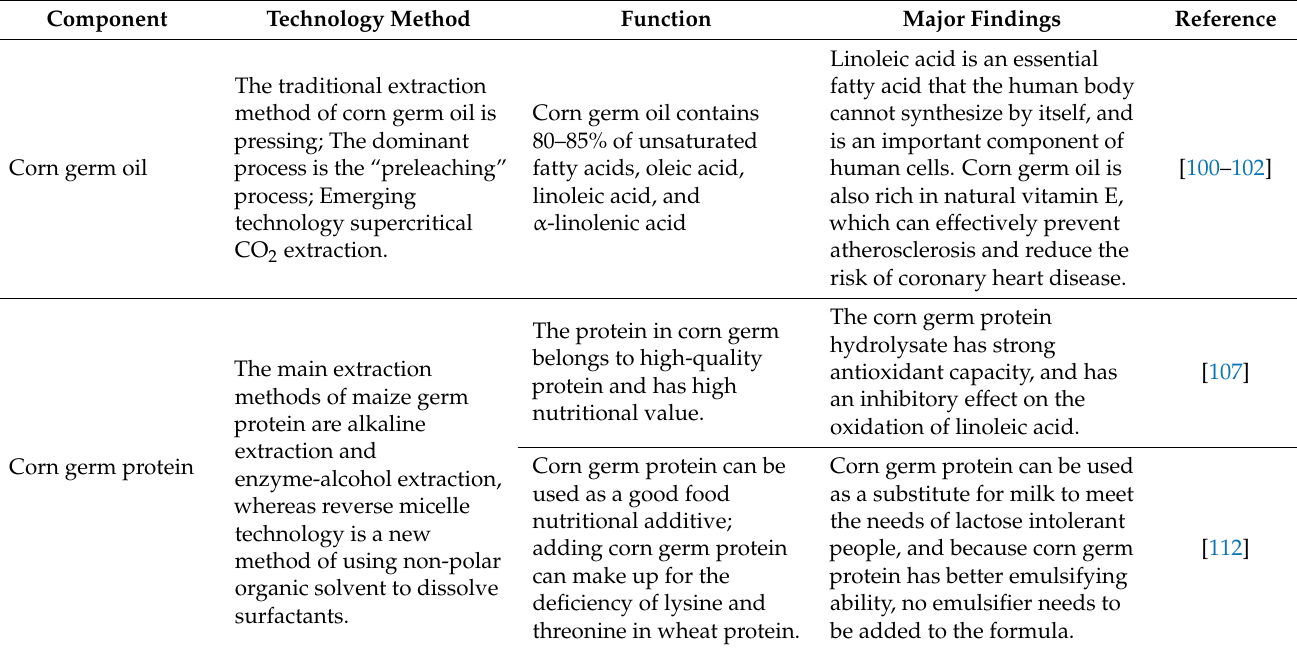
Table 4. The main component, technology method, function, and major findings of corn